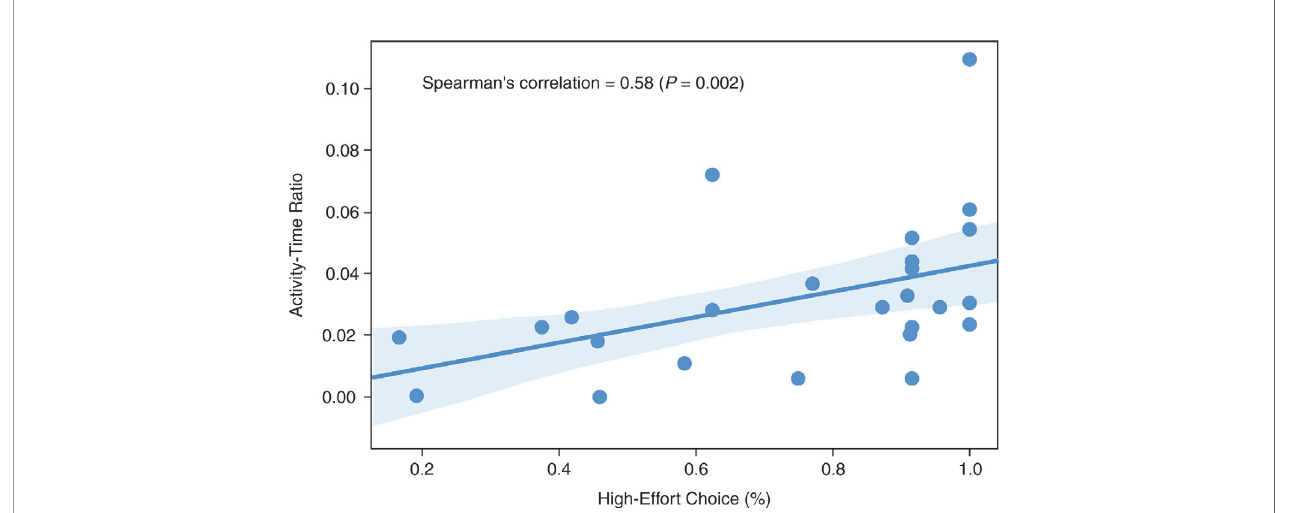
FIGURE 1 | Spearman ’ s correlation between activity – time ratio and high-effort choice (Spearman ’ s r = 0.58; P =